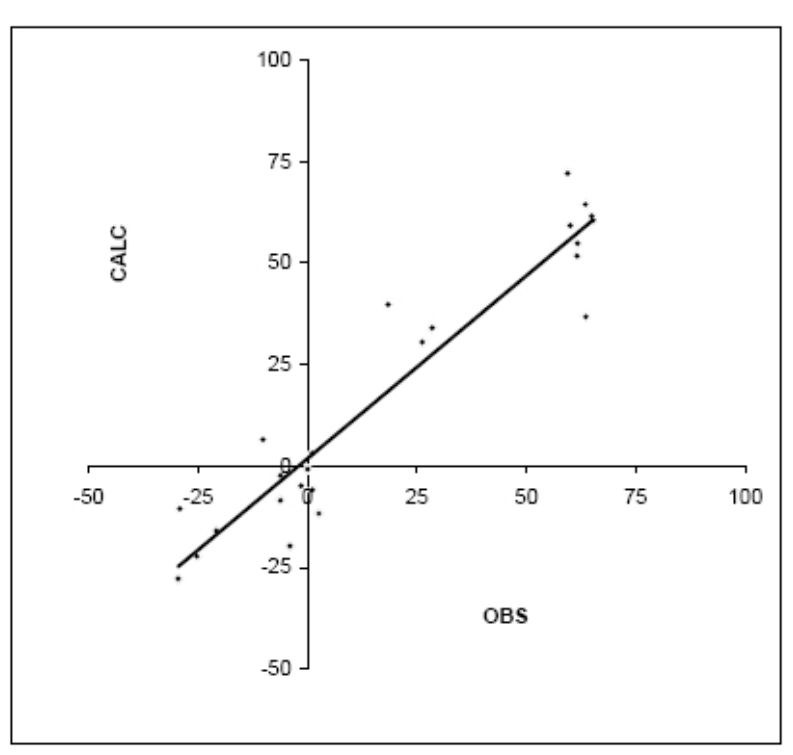
Fig. 3 Correlation between observed ( AA FL ) and calculated antioxidant activity values according to Eq.